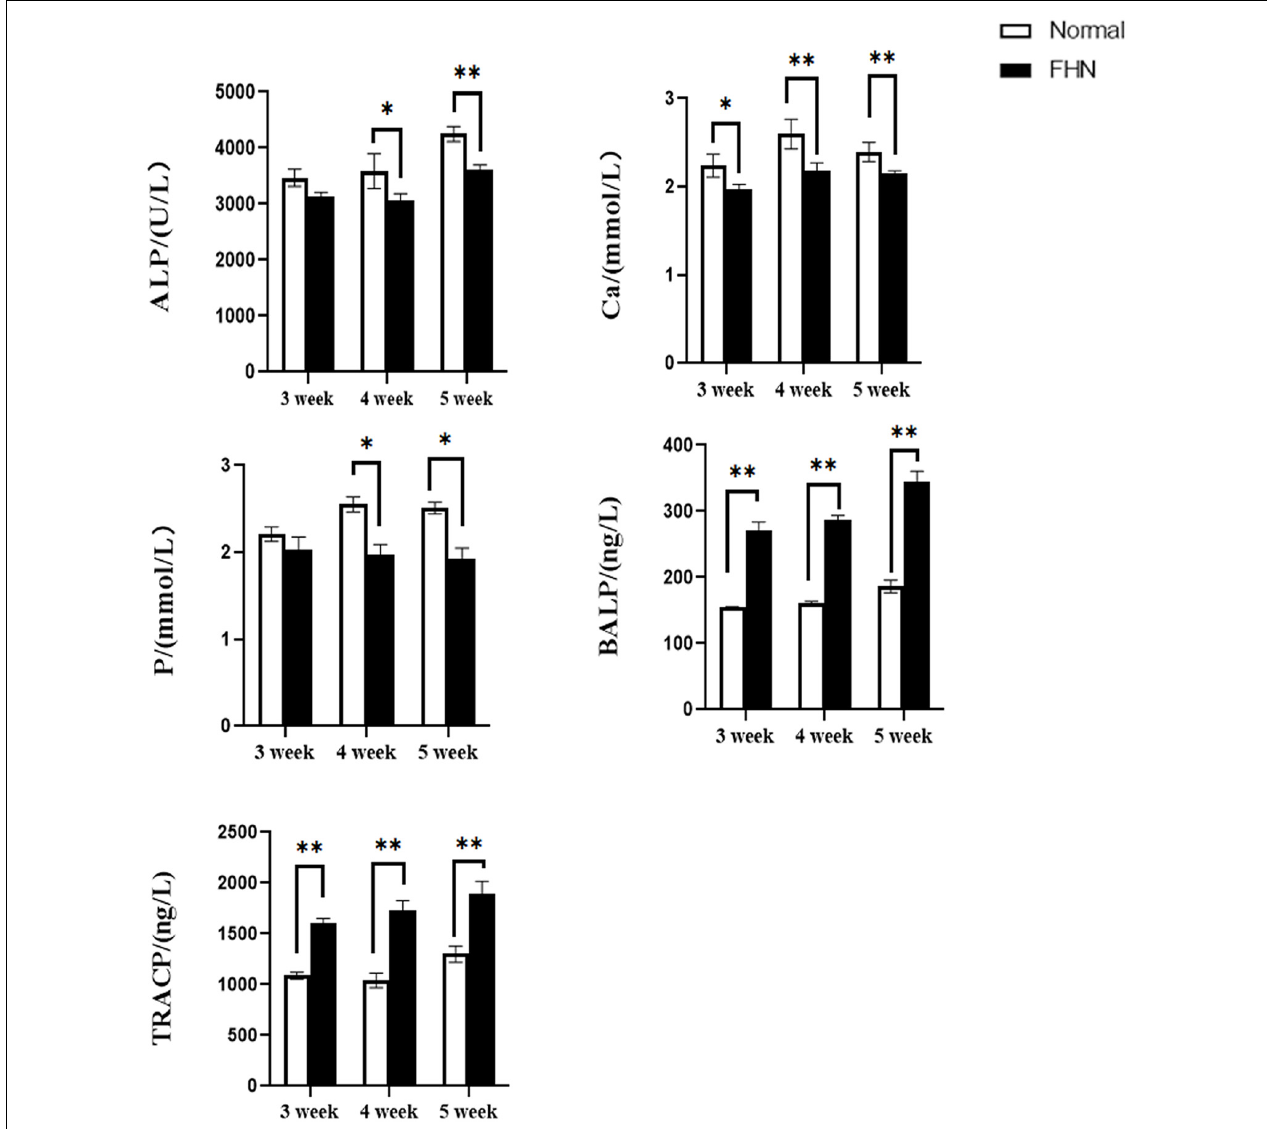
FIGURE 6 | The changes of serum biochemical indicators and bone metabolism. ∗ indicates a significant difference ( P < 0.05). ∗∗ indicates an extremely significant difference ( P <